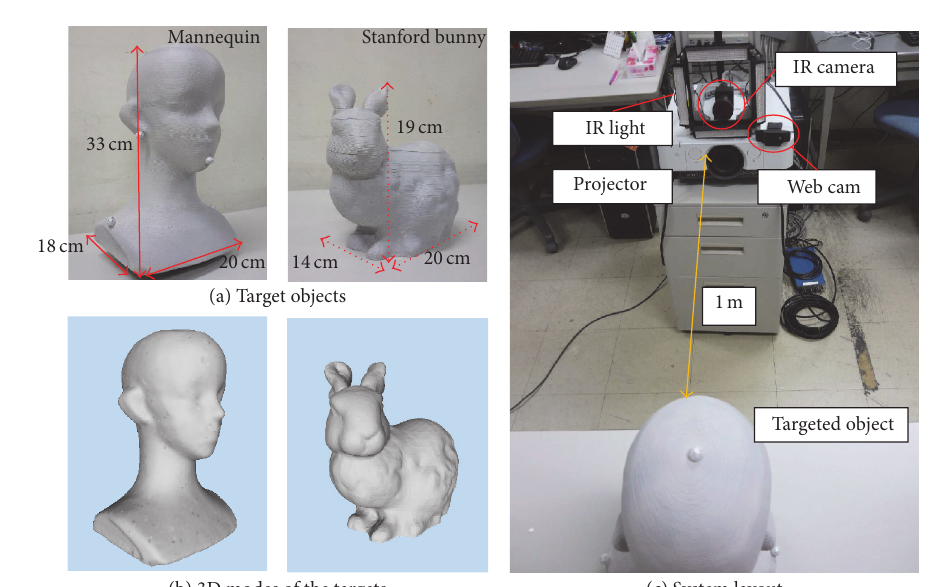
Figure 7: Experimental